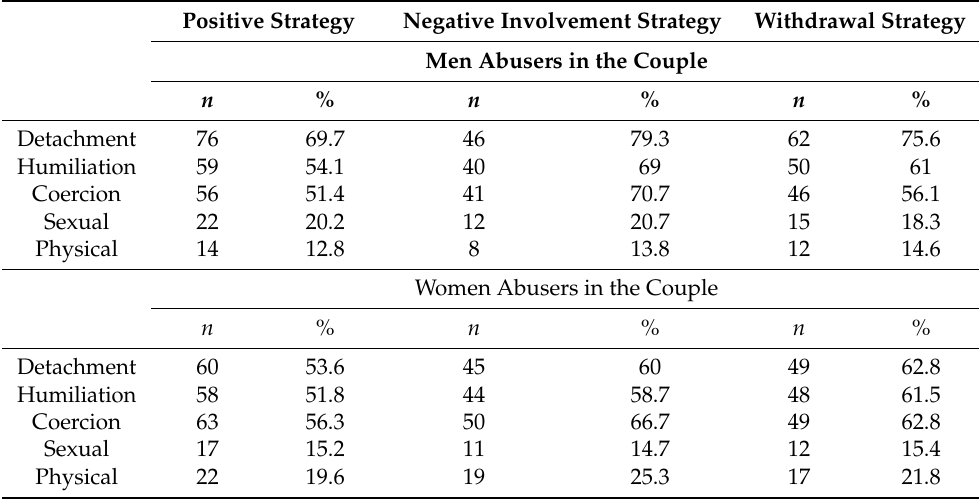
Table 8. Prevalence of the occurrence of conflict resolution strategies (CRSI) of men abusers and women abusers in the couples. Positive